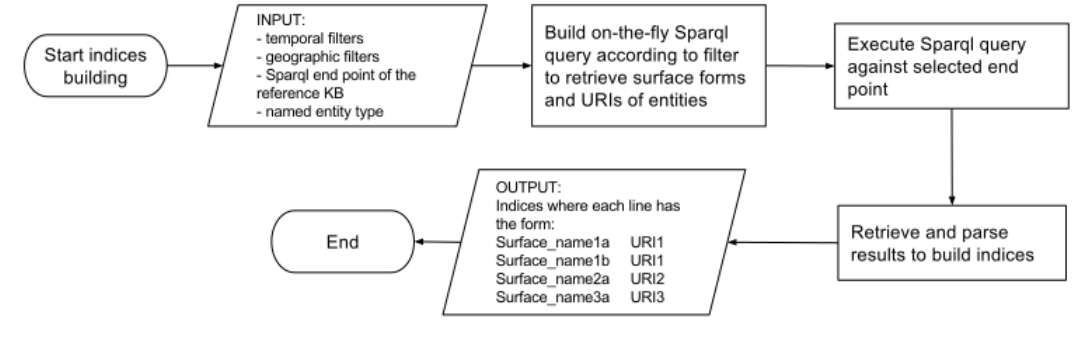
Figure 3. Flowchart describing the domain-adapted data extraction performed by REDEN during candidate retrieval